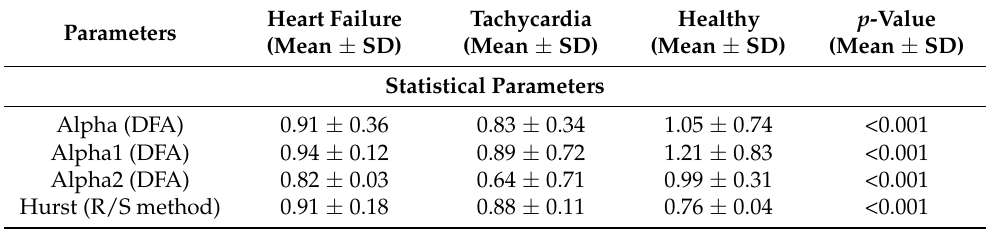
Table 6. Parameters of the nonlinear analysis of the studied records.